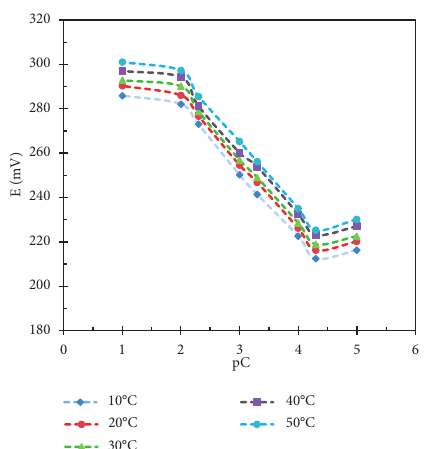
Figure 5: Effect of temperature on DES.RNK sensor response.